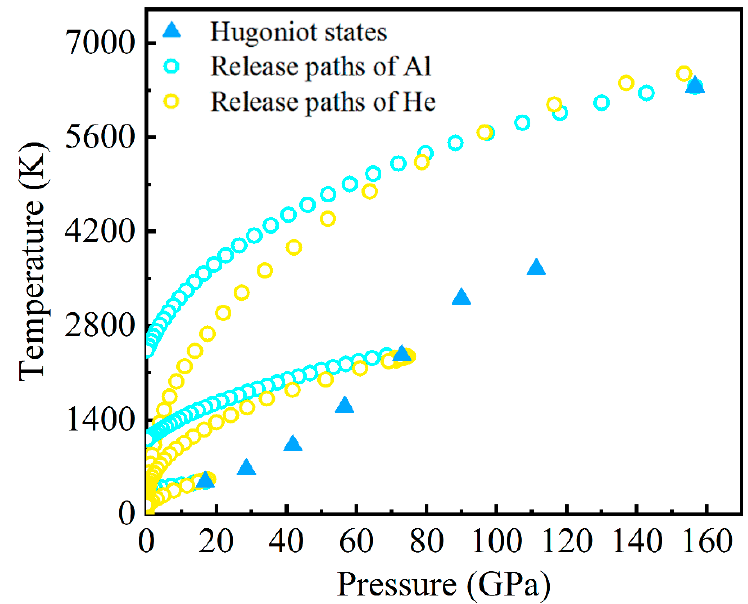
Figure 2. T - P Hugoniot (solid triangles) and some typical release paths (hollow